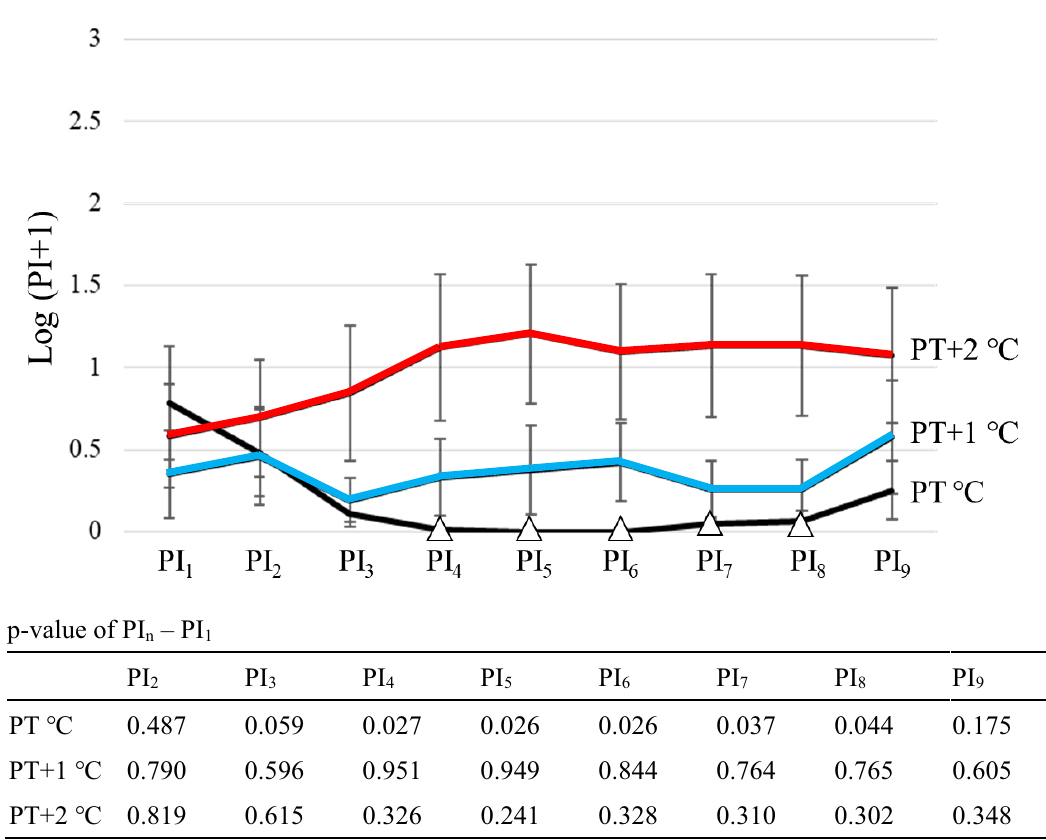
Figure 3. TSSP response patterns in healthy volunteers with no pain (female only: n = 15). Open triangle showed that PI